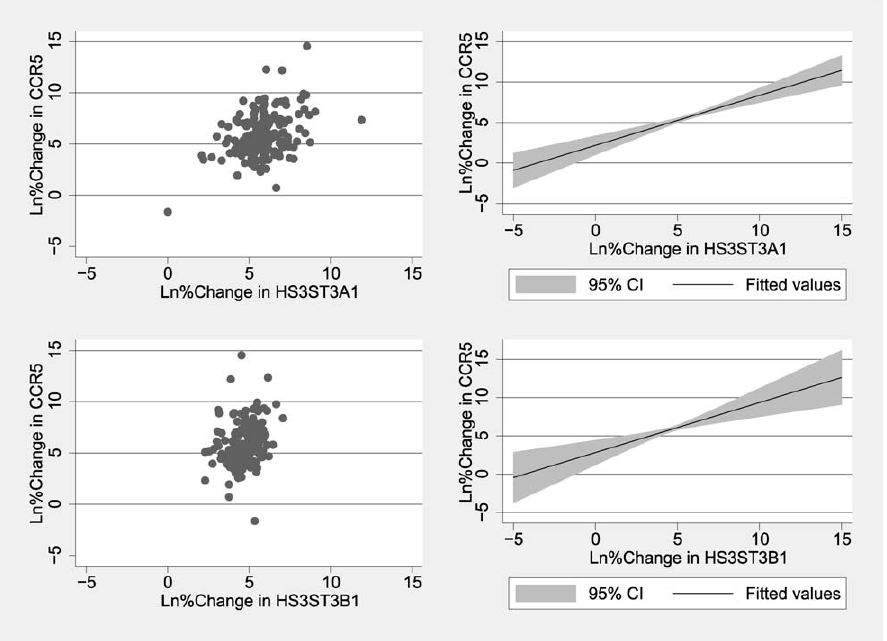
Figure 1. Pattern of association between placental expression of heparan sulfate genes and CCR5 . Scatter Plots (left) and Predicted Linear Plots (right).